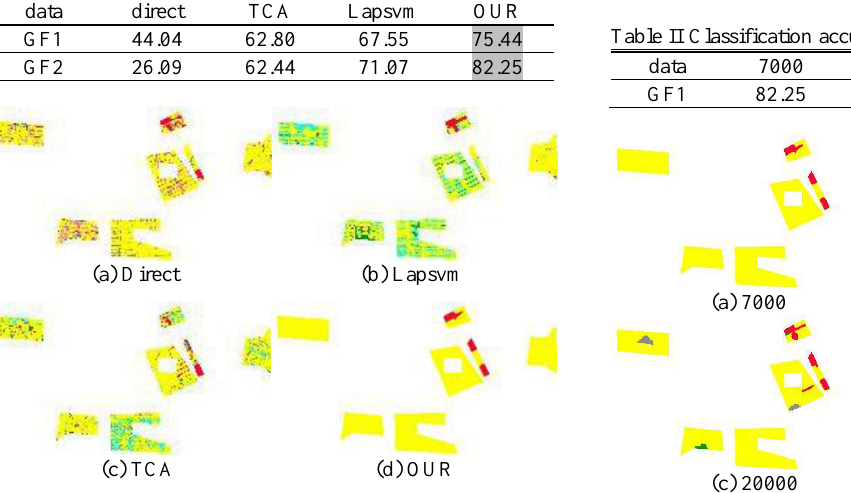
Fig.8 Classification maps on the small GF1 data sets.